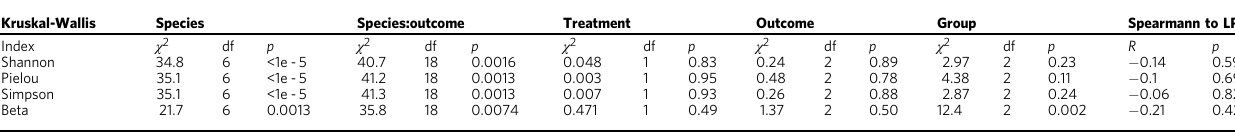
A Kruskal-Wallis test was performed on the diversity indices. “ χ 2 ” indicates the Chi-square test, “ p ” indicates the p -value.